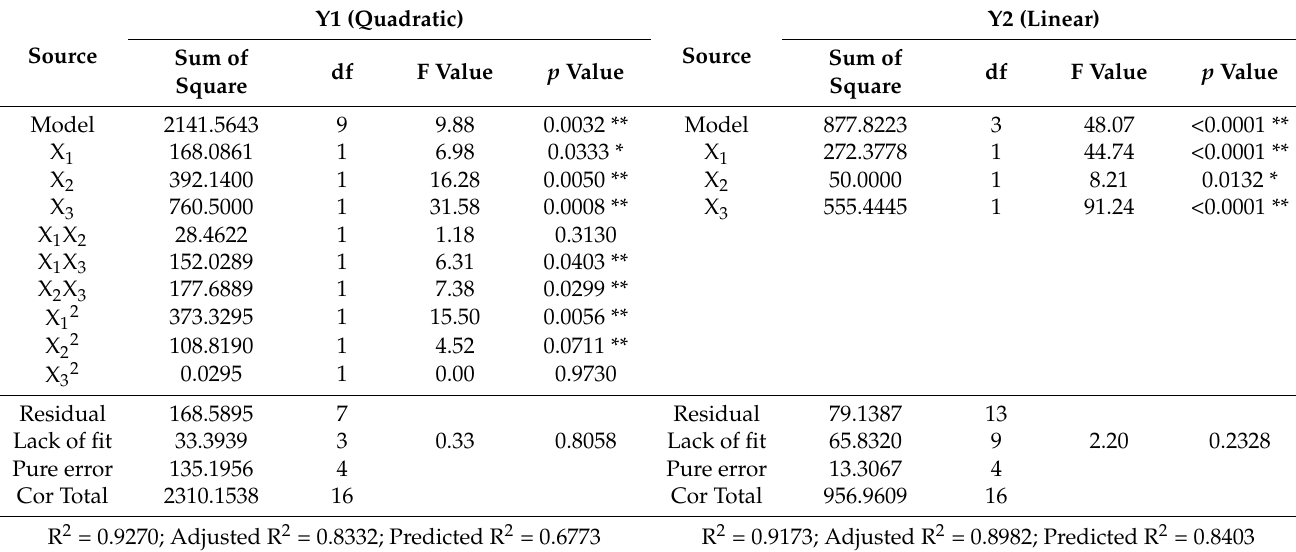
Table 4. ANOVA results for experimental